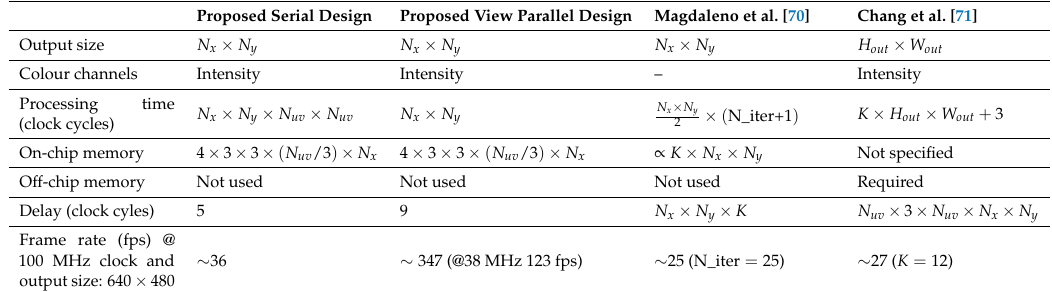
Table 11. Comparison with other depth from light field implementations on